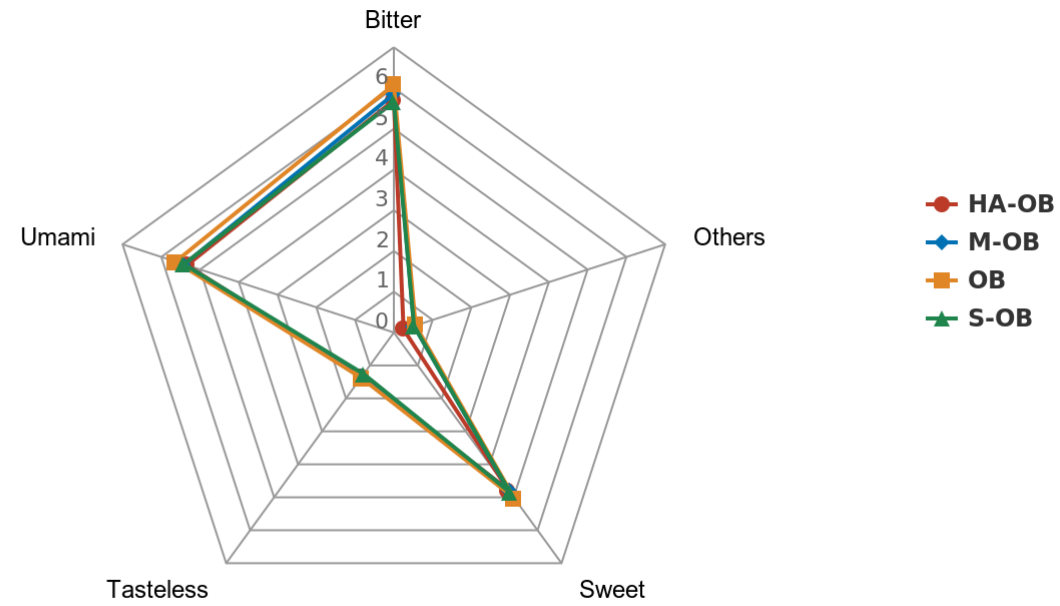
Figure 2. Radar graph of the sensory results of pretreated oat bran. OB, Oat bran; S-OB, Steamed oat bran; M-OB, Microwaved oat bran; HA-OB, Hot air dried oat bran. Sweet = Ala + Gly + Ser + Thr + Pro; Umami = GLU + ASP; Bitter =Val + Met + Leu + Ile + Phe + His + Arg; Tasteless = Lys + Tyr; Other = Cys.